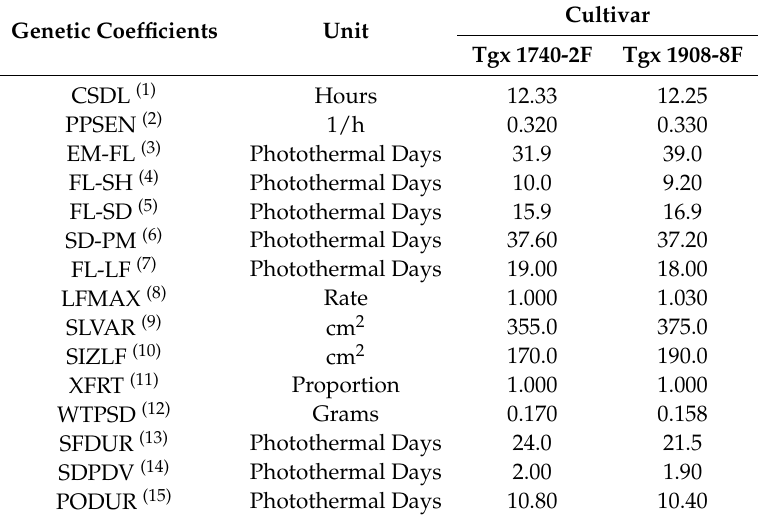
Table 3. Genetic coefficients used for the CROPGRO-Soybean model, calibrated for cultivars planted in Angónia, Tete, in 2009/2010 grown season. Genetic Coefficients